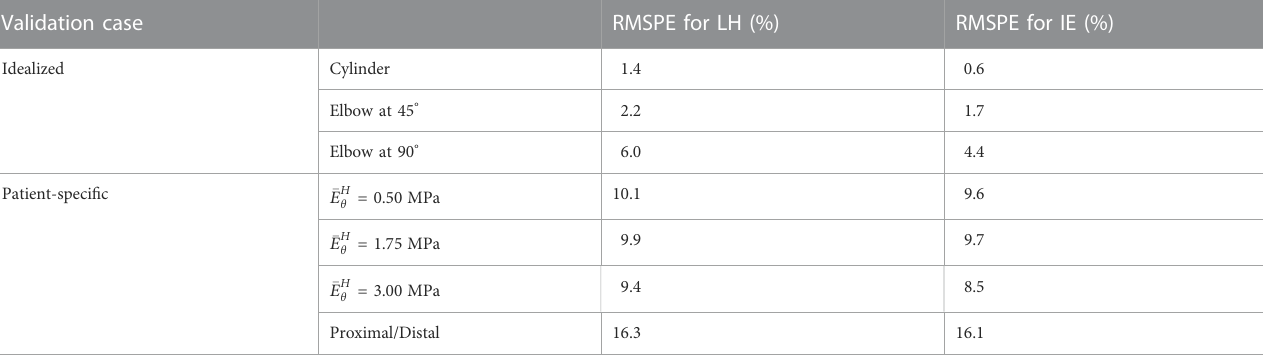
TABLE 1 Table summarizing the Young ’ s modulus RMSPE, relative to the reference values for all validation cases, including idealized and patient-speci fi c. Validation case RMSPE for LH (%) RMSPE for IE